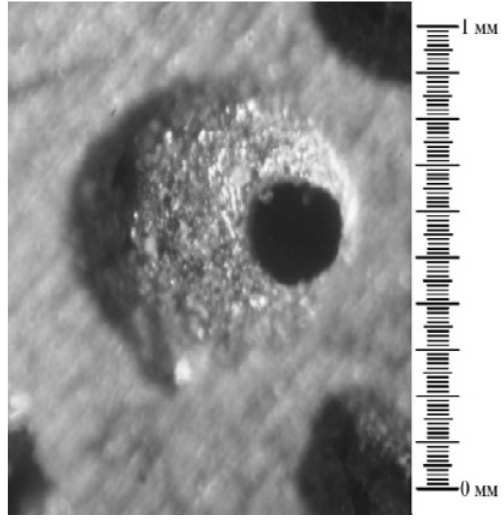
Figure 3. Photomicrograph of flat surface of replicated foam.